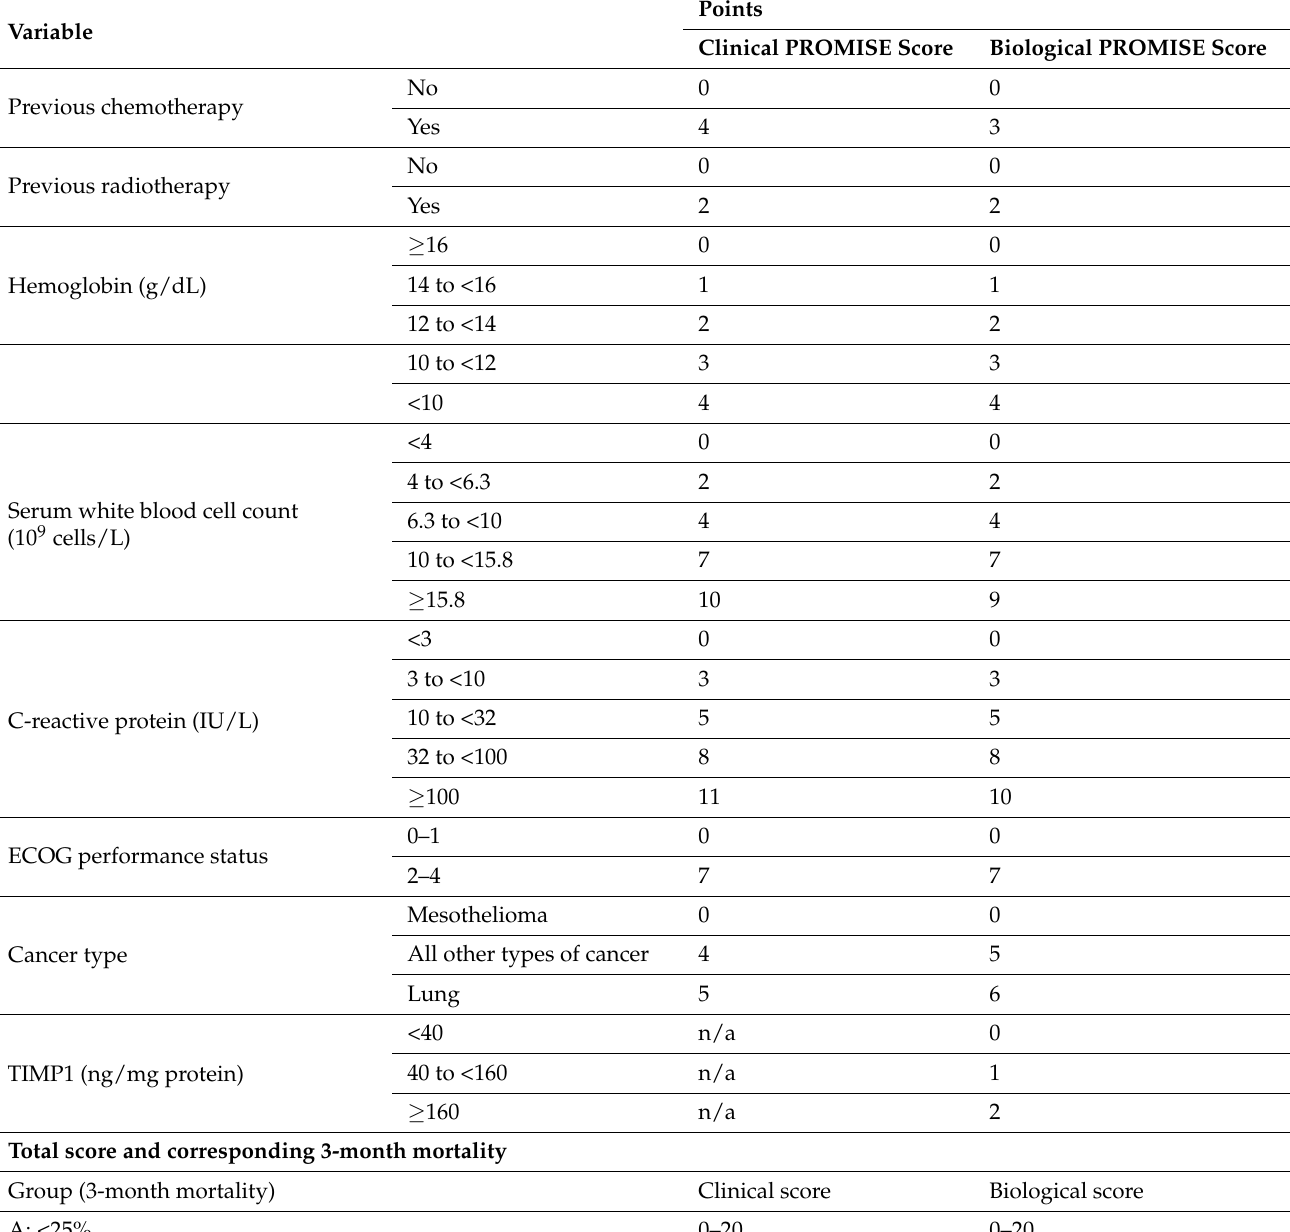
Table 1. Clinical and biological PROMISE scores (adapted from Psallidas et al. [55]). Points Clinical PROMISE